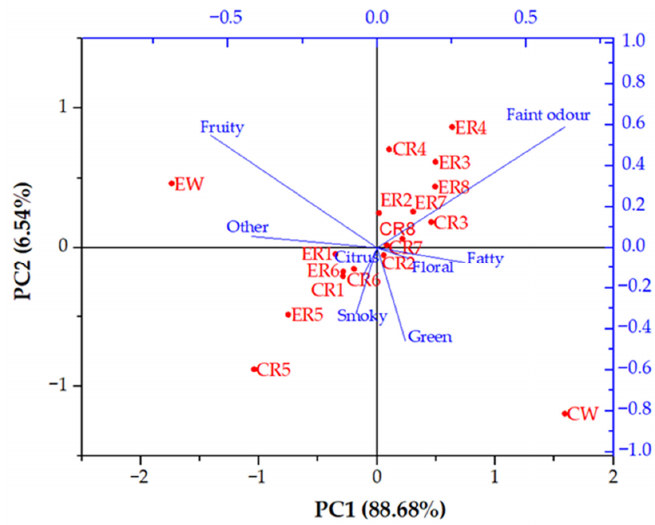
Figure 4. Principal component analysis (PCA) biplot of the aroma compounds identified in the initial wines and the reverse osmosis retentates. Abbreviations: CW—initial conventional wine; EW—initial ecological wine; CR—reverse osmosis retentate of the conventional wine; ER—reverse osmosis retentate of the ecological wine; 1—2.5 MPa, with cooling; 2—3.5 MPa, with cooling; 3—4.5 MPa with cooling; 4—5.5 MPa, with cooling; 5—2.5 MPa, without cooling; 6—3.5 MPa, without cooling; 7—4.5 MPa, without cooling; 8—5.5 MPa, without cooling.. Principal component 1 (PC1) accounted for 88.68% and principal component 2 (PC2) accounted for 6.54% of the total variance. PC1 separated the samples according to the ap-